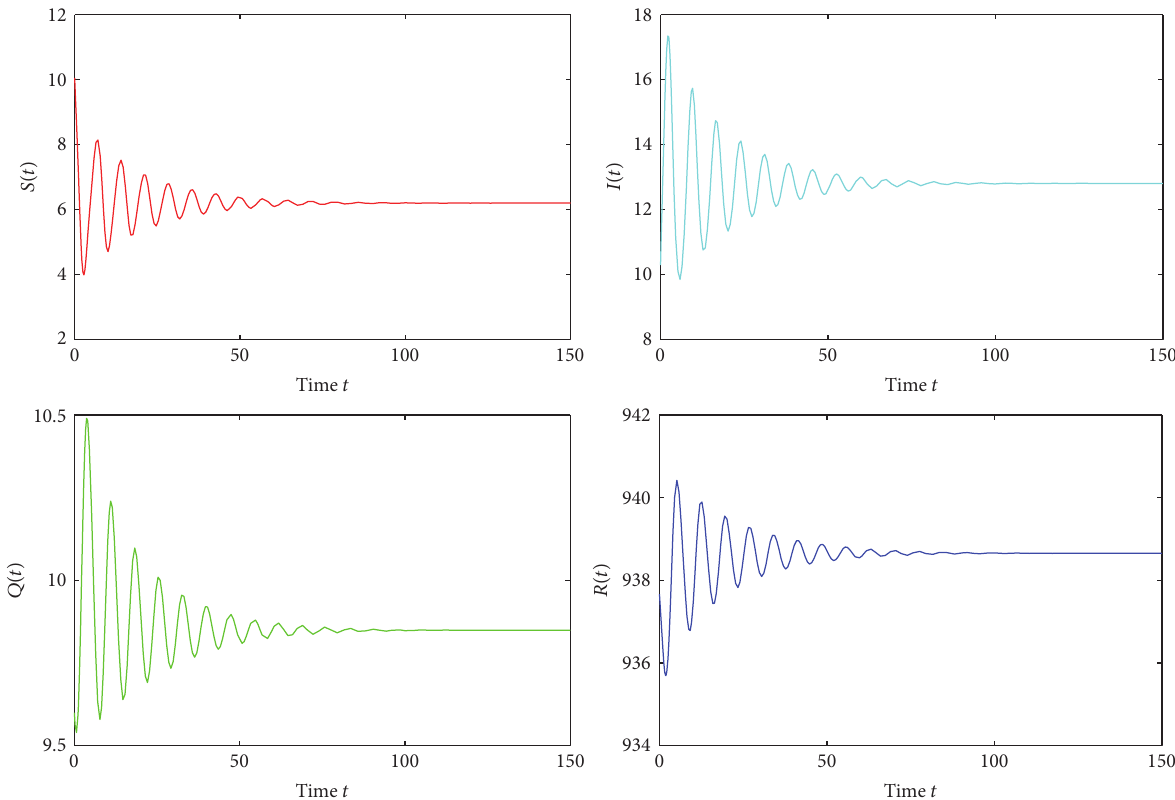
Figure 19: The trajectory of 𝑆 , 𝐼 , 𝑄 , and 𝑅 when 𝜏 2 = 1.235 < 1.3485 = 𝜏 󸀠 20 and 𝜏 1 = 0.65 .